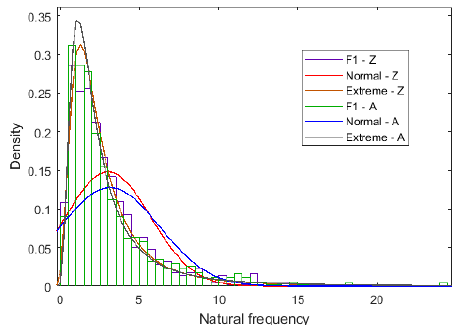
Figure 5. Probability density distribution for the first order natural frequencies (the unit for the natural frequency is THz).